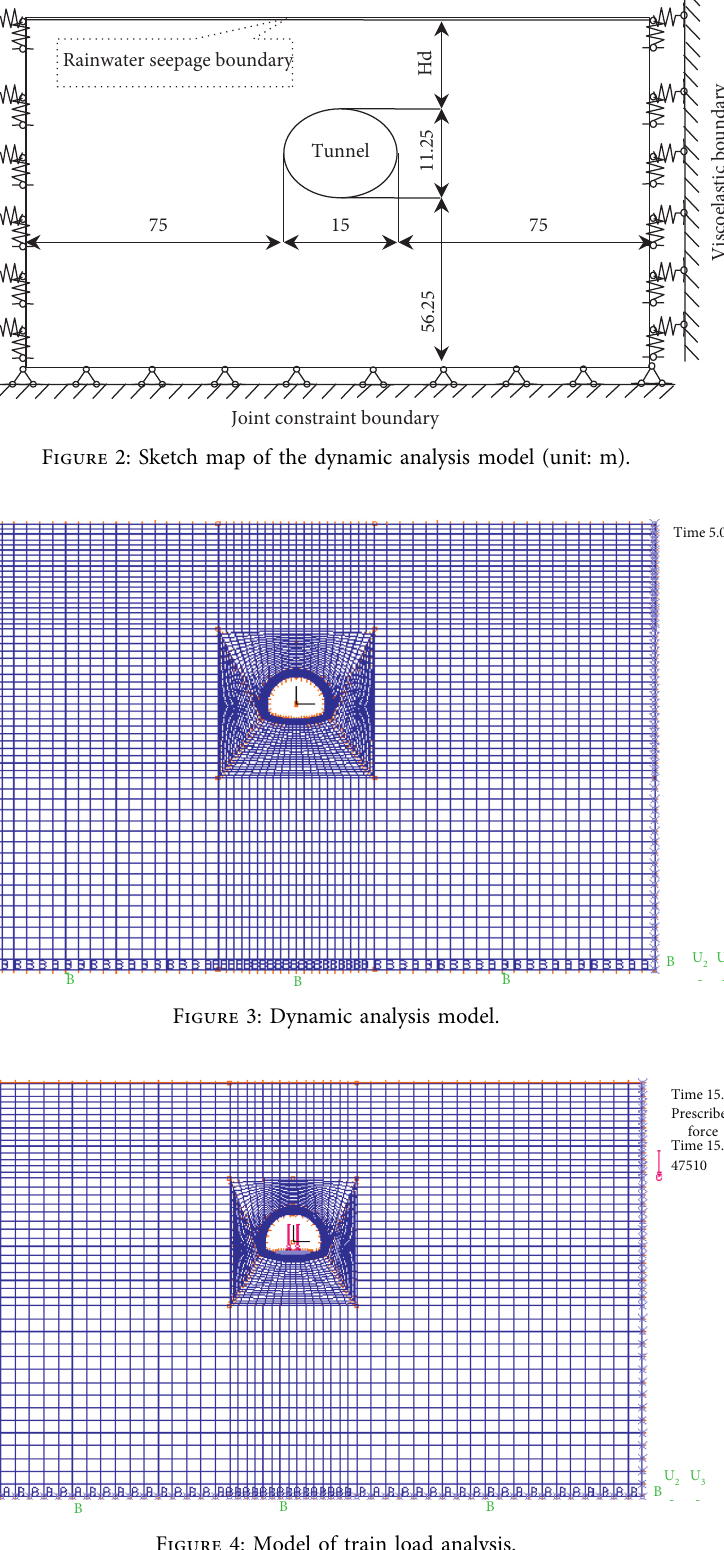
Figure 4: Model of train load